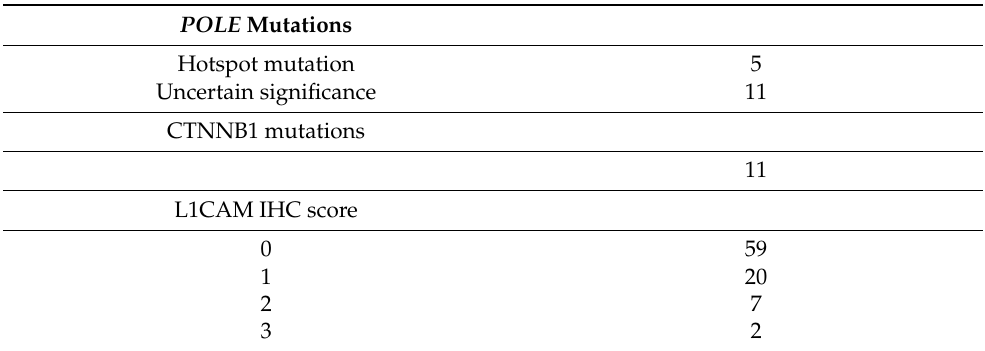
Table 3. Pathogenic POLE and CTNNB1